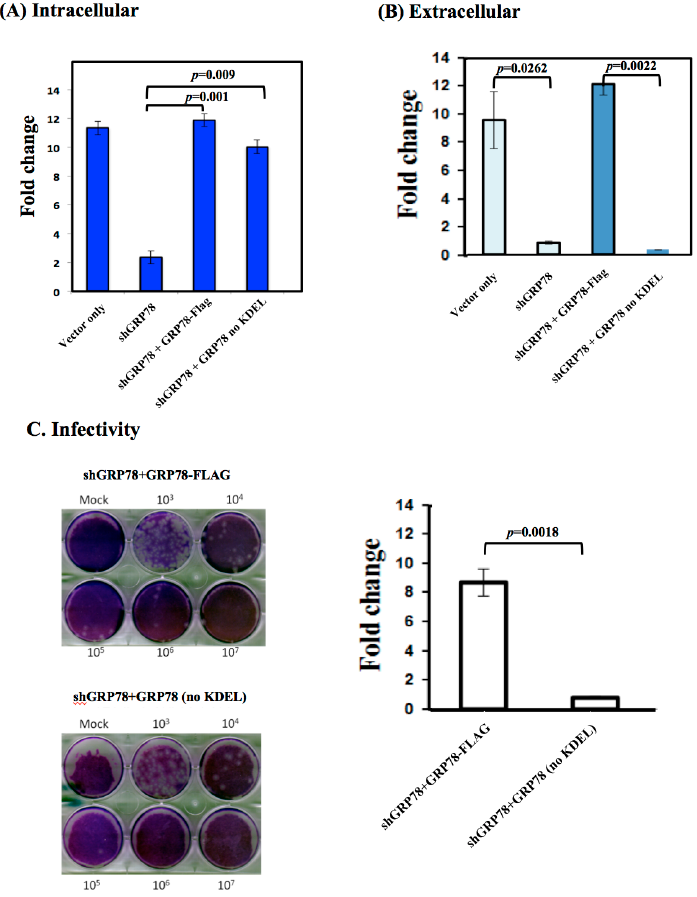
Figure 3. The C-terminal tetra-peptide KDEL within GRP78 is required for the production of infectious viral progeny. The GRP78 knocked down BHK-21 cells had ectopic overexpression of GRP78 or KDEL-motif-truncated GRP78 proteins followed by infection with JEV. ( A ) The cells were then harvested and prepared for the determination of JE viral RNA as described in the Materials and Methods; ( B ) The cultured medium was collected, and the JEV RNA was quantified by RT-qPCR as described in the Materials and Methods. The fold change of the JEV RNA level is defined as the relative increase amount of viral RNA in comparison to siGRP78-treated cells; ( C ) The viral progeny from the ectopically-expressed GRP78 or KDEL-truncated GRP78 proteins in the GRP78 knocked down cells were quantified by plaque assay. The virus titers are shown in PFU/mL. The data shown here are the means of three independent experiments with standard errors. The p -values indicate a significant difference between ectopically-expressed of GRP78 and KDEL-truncated GRP78 in the JEV-infected GRP78 knocked down BHK-21 cells. Abbreviations: vector only, BHK-21 cells were transfected with scramble siRNA followed by infection with JEV; shGRP78, the GRP78 stable knocked down BHK-21 cells infected with JEV; shGRP78 + GRP78-Flag, the GRP78 knocked down BHK-21 cells were ectopically expressed with GRP78-Flag protein, followed by infection with JEV; shGRP78 + GRP78-Flag no KDEL, the GRP78 knocked down BHK-21 cells were ectopically expressed with KDEL-motif-truncated GRP78 protein, followed by infection with